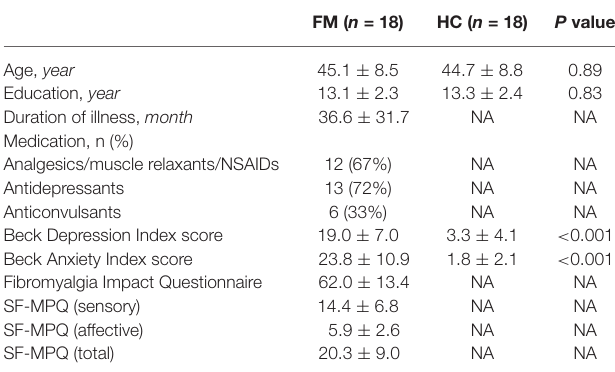
TABLE 1 | Demographic and clinical characteristics of study participants